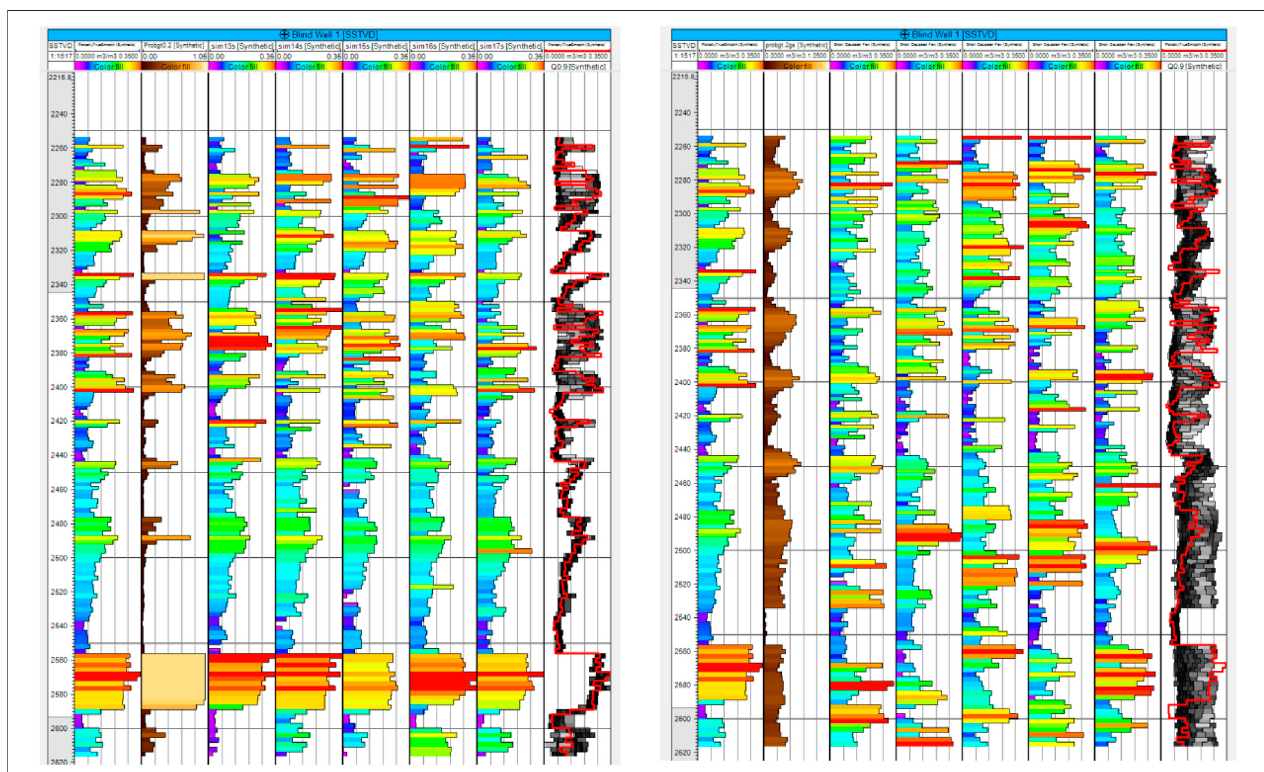
FIGURE 16 | Left is true porosity, while the right-hand side is